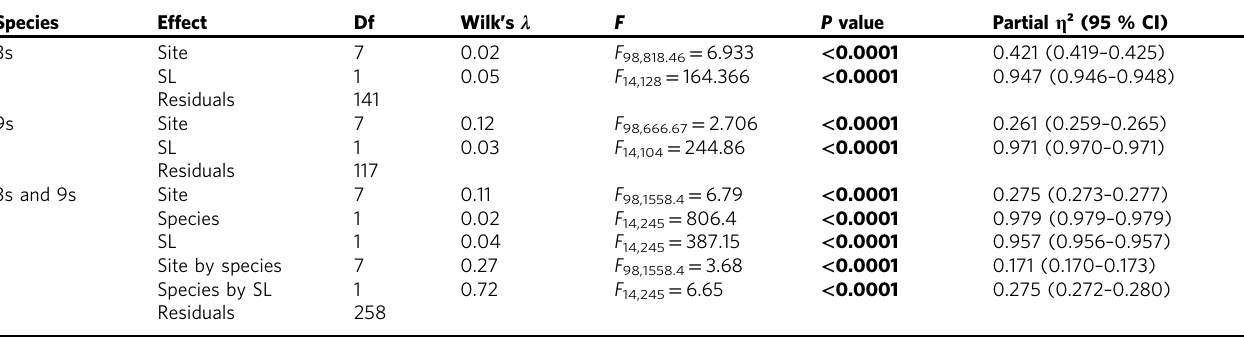
Table 1 Single species and two species MANCOVA on 14 morphological traits in coexisting three-spined (3s) and nine-spined (9s) stickleback populations from eight sites